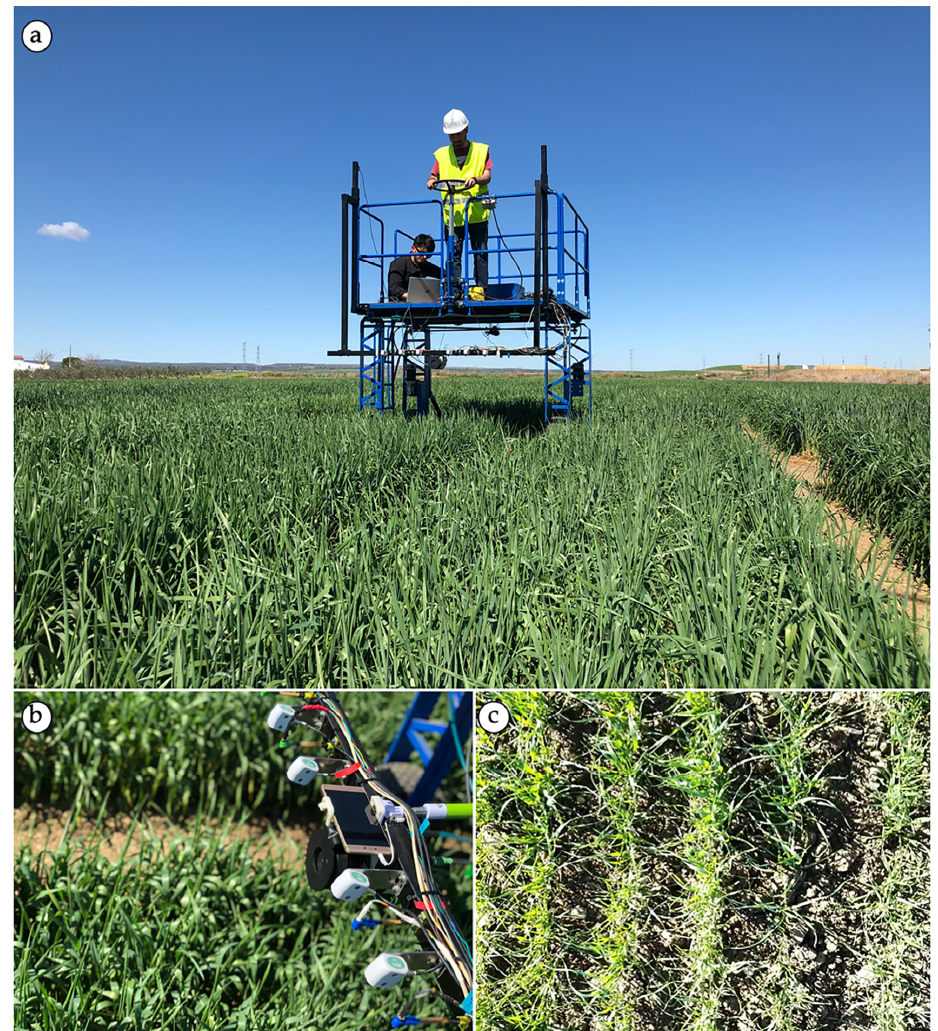
Figure 4. Image acquisition using the high-throughput phenotyping platform (HTPP). ( a ) A picture